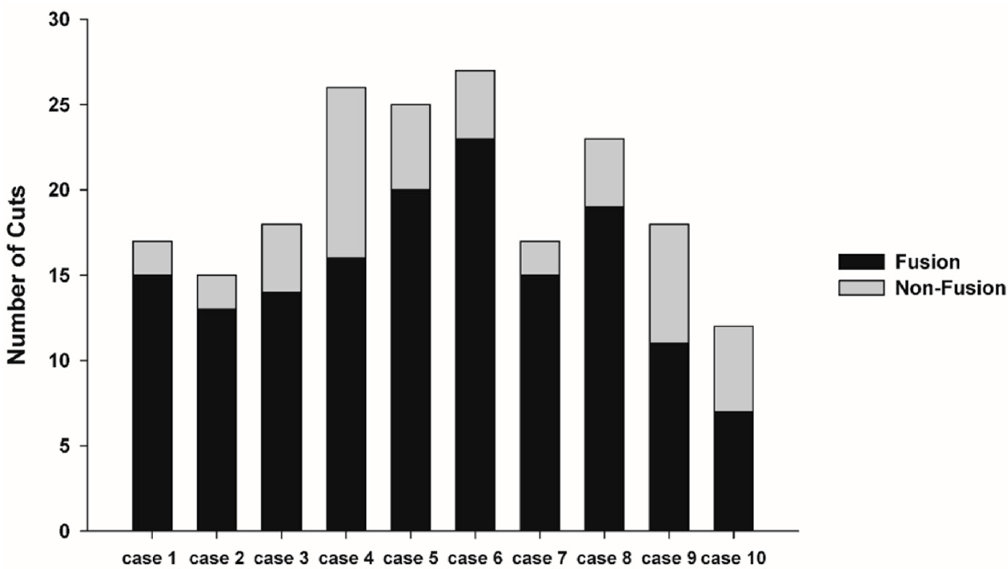
Figure 4. Linear mixed-effects model (LMEM) showed no evidence of significant difference between each cases (F(9, 9) = 0.900, p = 0.561), but significant differences for fusion status (F(1, 9) = 40.438, p < 0.001).